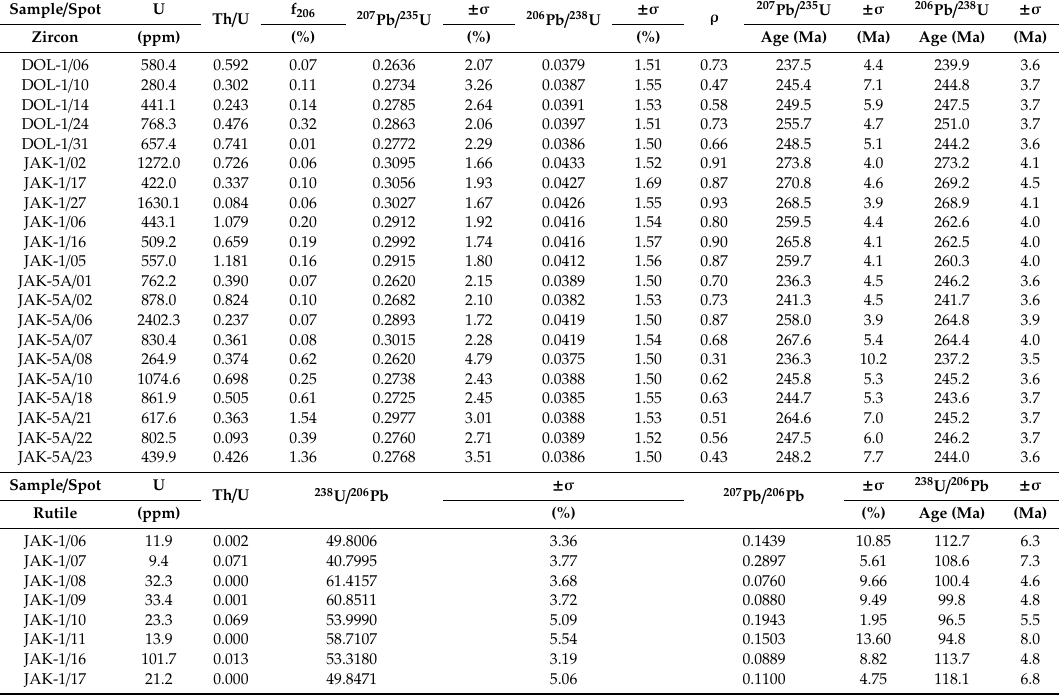
Figure 20. ( a ) Examples of rutile CL (SEM-CL) images from metabasalt s. JAK-1 in Jaklovce cross-section (Figure 6, Figure 7b,c, Figure 16a) with dated spots. ( b ) Rutile U–Pb SIMS age diagram from this sample. Table 3. Data used in Concordia age Zrn and Rt calculations. An additional set of isotopic data is in Table S2. Sample/Spot